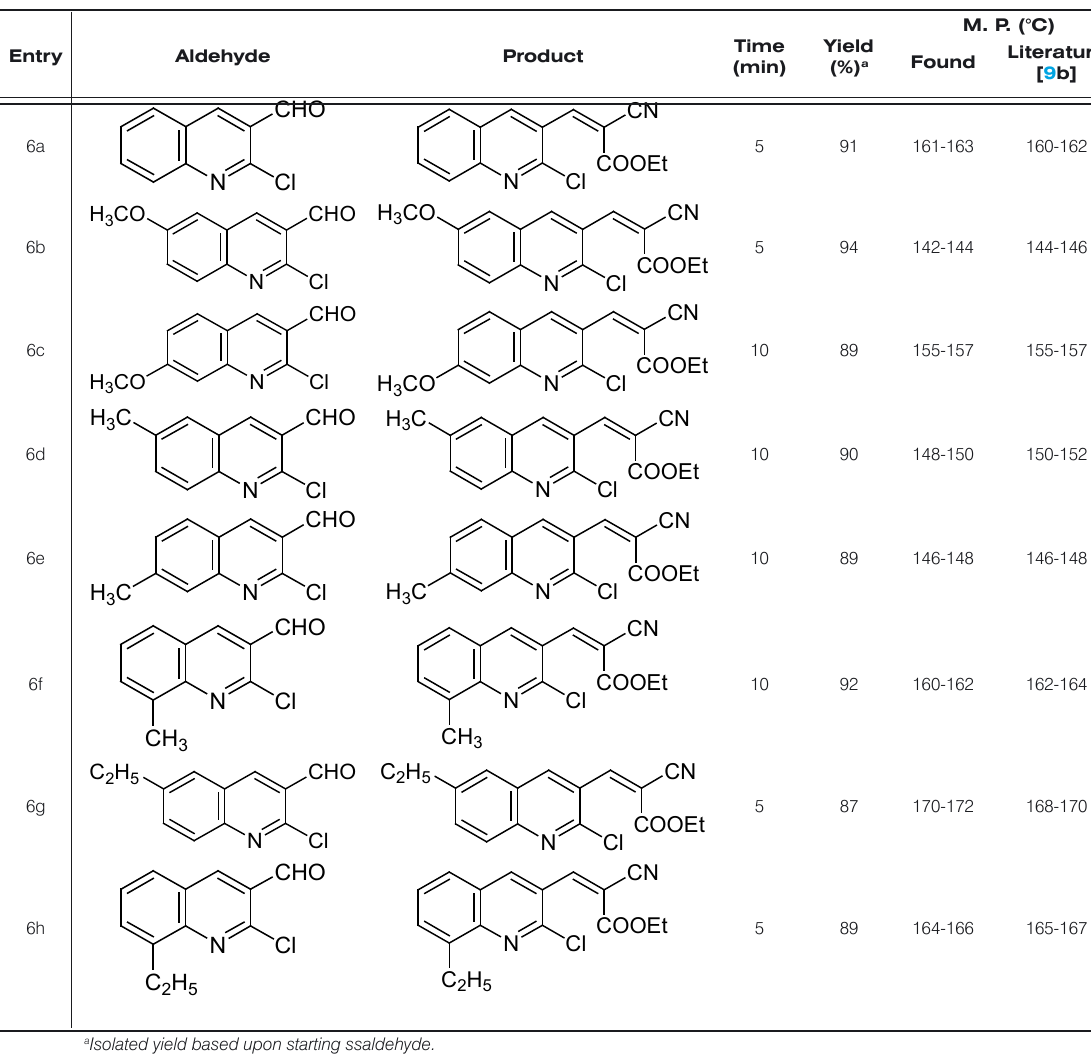
Table 3. Cellulose sulphuric acid catalyzed Knoevenagel reaction by grinding at room temperature (Scheme 2)